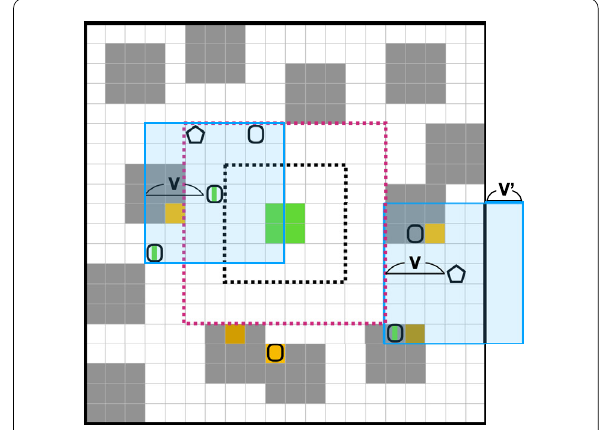
Figure 1 Example of environment and observable ranges